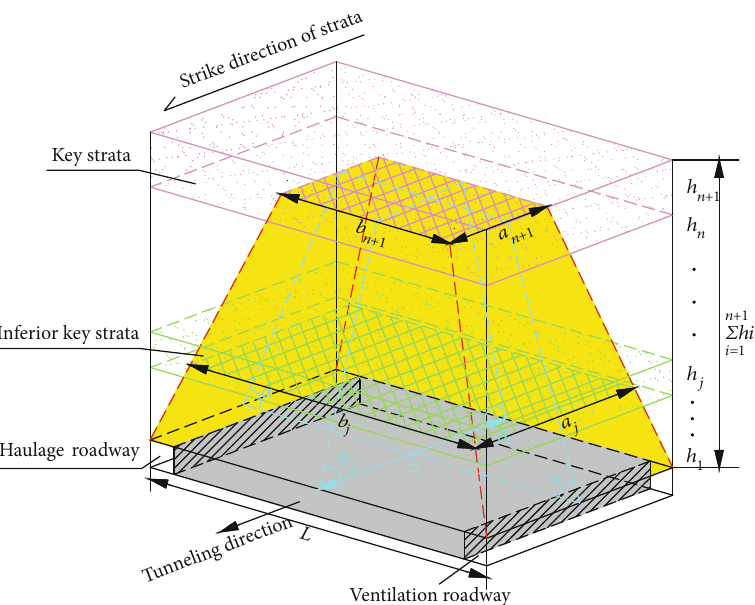
Figure 3: Graphic model of the fracture mode of the overlying strata in the working